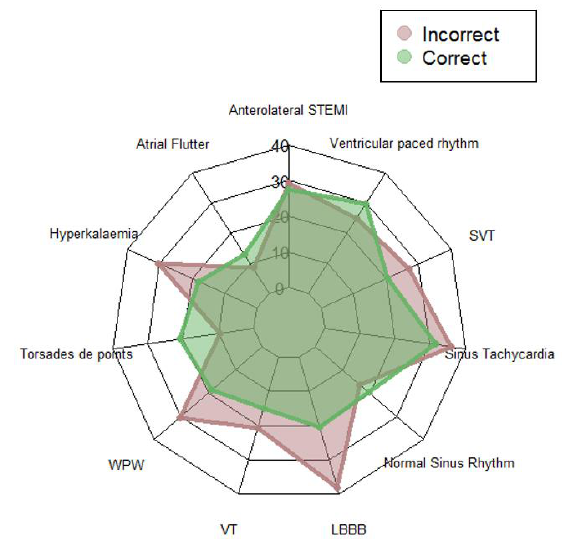
Figure 3. Average scanpath lengths for each stimulus for correct and incorrect groups The aggregated scanpath lengths (with truncation) repre- senting the scanpath as the sequence of AOIs visited are shown in the web diagram in Figure 3 for both groups for each ECG. The average length of the scanpaths across all stimuli for the combined groups was 23 AOIs ( SD = 18.25, Mo =9,